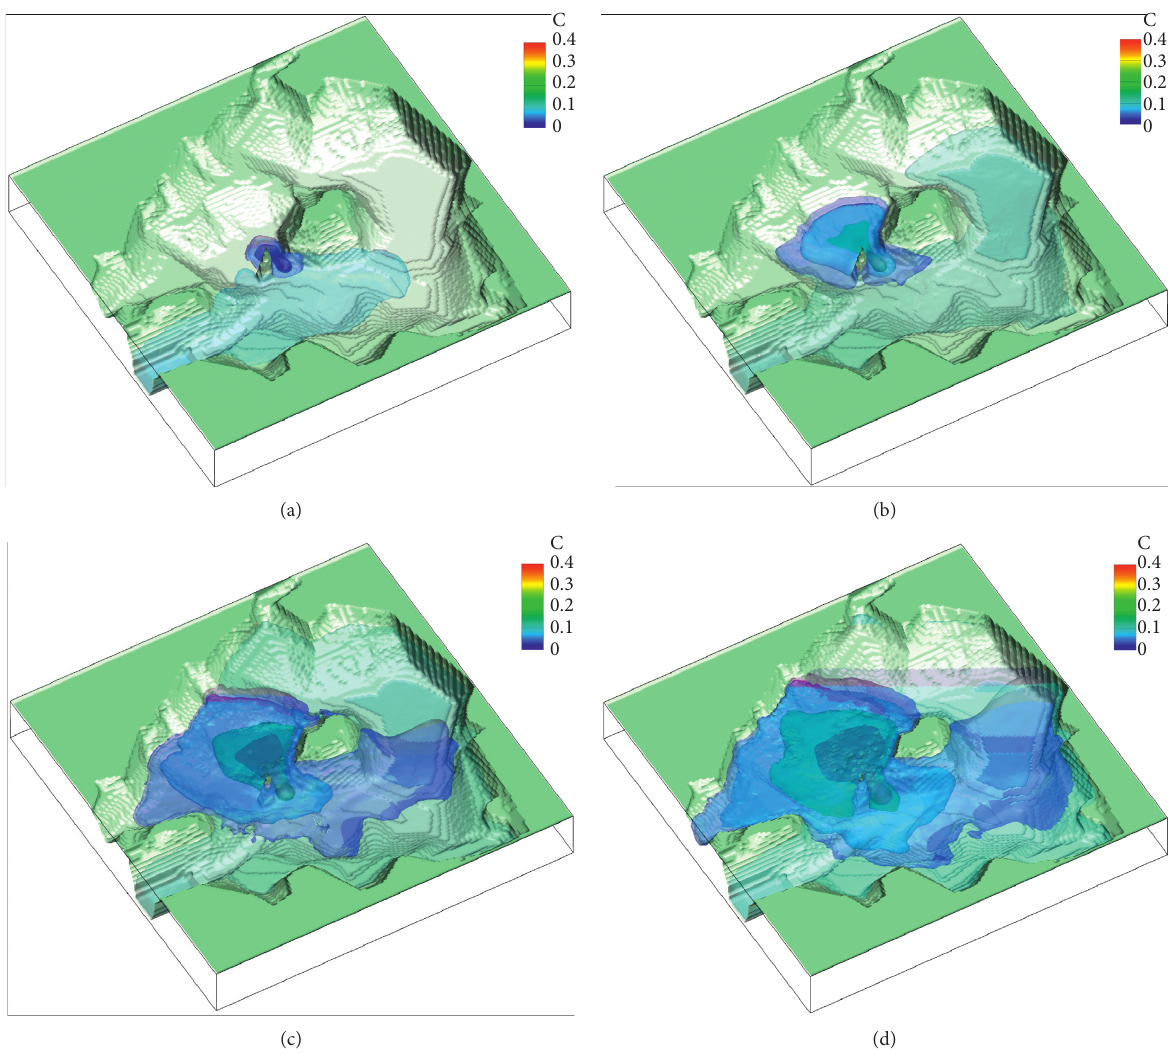
Figure 13: Isoconcentration surface distribution of an upper reservoir: (a) t � 5min, (b) t � 15 min, (c) t � 85min, and (d) t �